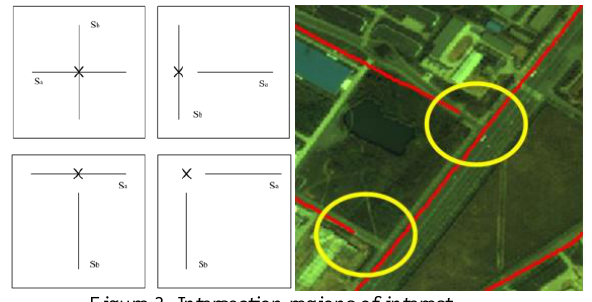
Figure 3. Intersection regions of interest